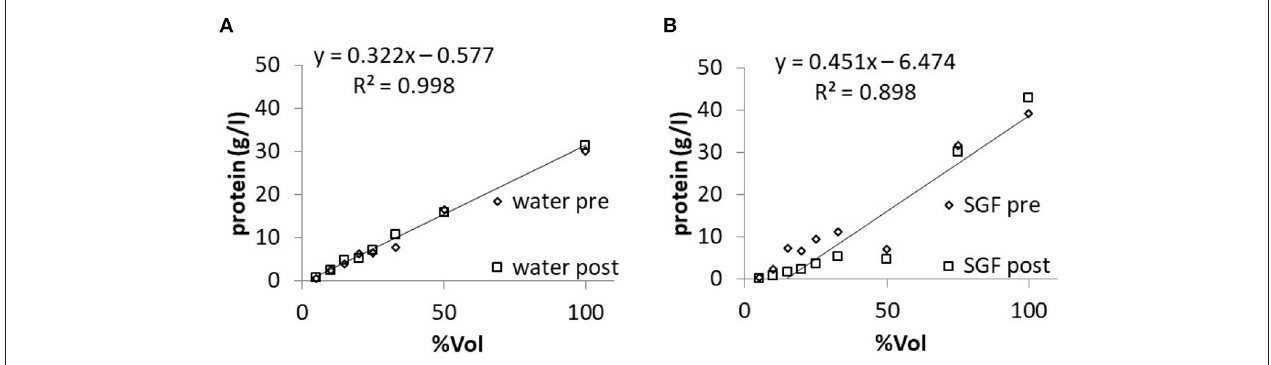
FIGURE 5 | Relationship between measured protein concentration and nutrition formula (Fresubin original fibre) concentration in water (A) or in SGF (B) before (“pre”) and after (“post”) 240-min of incubation in the respective medium; single measurements. The normalized standard error of the slope of the regression line was 2.0% for (A) and 12.7% for (B) before